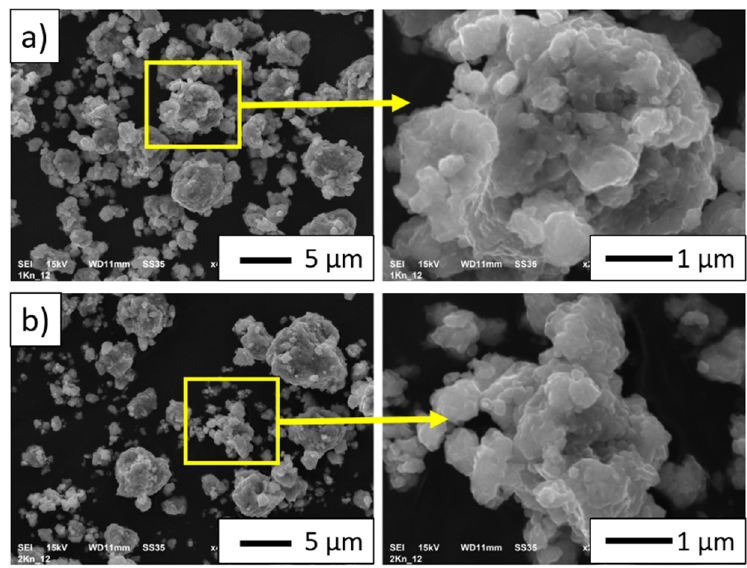
Figure 4. Microphotographs of the powder particles of the mechanic alloying products: ( a ) NiAl- 10%Al 2 O 3 powder; ( b ) NiAl-20%Al 2 O 3 powder.